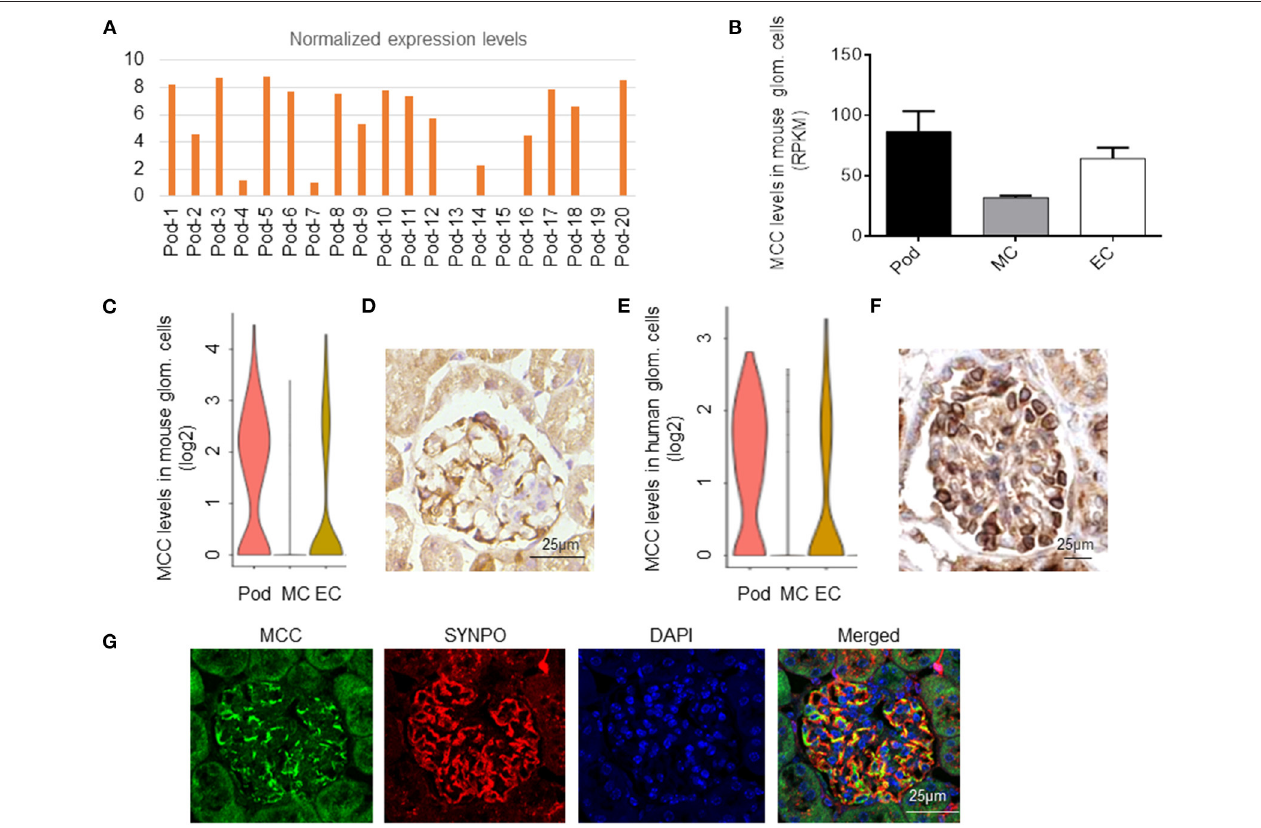
FIGURE 1 | MCC expression in podocytes in mouse and human. (A) MCC mRNA was detected in 18 out the 20 mouse podocytes subjected to single-cell RNA-seq analysis (GEO: GSE88814). (B) MCC expression in mouse podocytes, mesangial cells and glomerular endothelial cells from the bulk sequencing of mouse glomerular cells (GEO: GSE123179). (C) MCC expression in glomerular cell types according to the database, KIT (http://humphreyslab.com/SingleCell/). (D) Immunohistochemical staining of MCC in a mouse glomerulus, showing a staining pattern characteristic of podocytes. (E) MCC expression in human glomerular cell types, podocytes (Pod), mesangial cells (MC) and endothelial cells (EC) according to the KIT database above. (F) The immunohistochemical staining of MCC from the Human Protein Atlas (www.proteinatlas.org) shows that MCC expression is relatively specific to podocytes. (G) Fluorescence co-immunostaining of MCC and SYNPO in mouse kidney, showing the localization of MCC in foot processes of